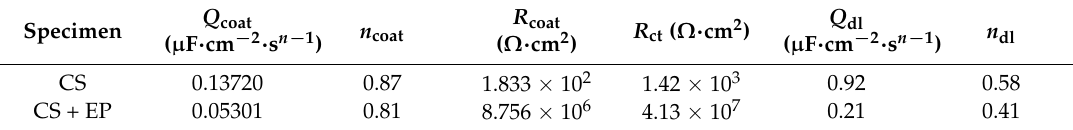
Table 4. The EIS simulation results for the CS + EP coated AZ31B Mg alloy.